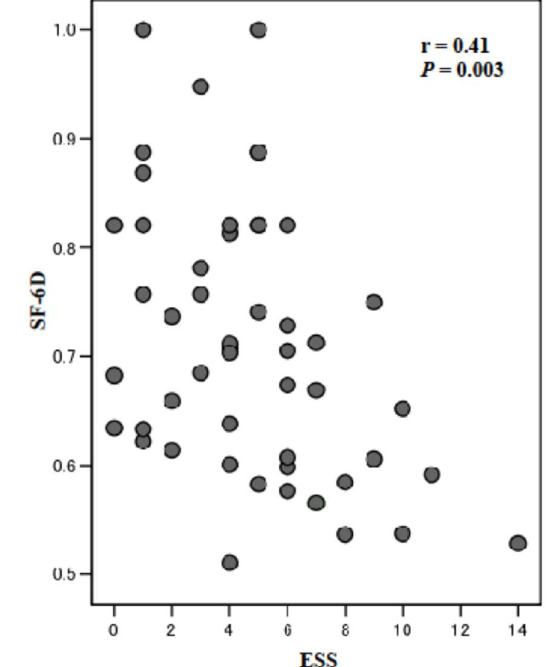
Figure 1. Relationship between daytime sleepiness and health utility in the study patients at 5 months after cardiac surgery. There was a significant negative correlation between mean ESS score and the SF-6D utility score in the patients. ESS, Epworth Sleepiness Scale; SF-6D, Short-Form